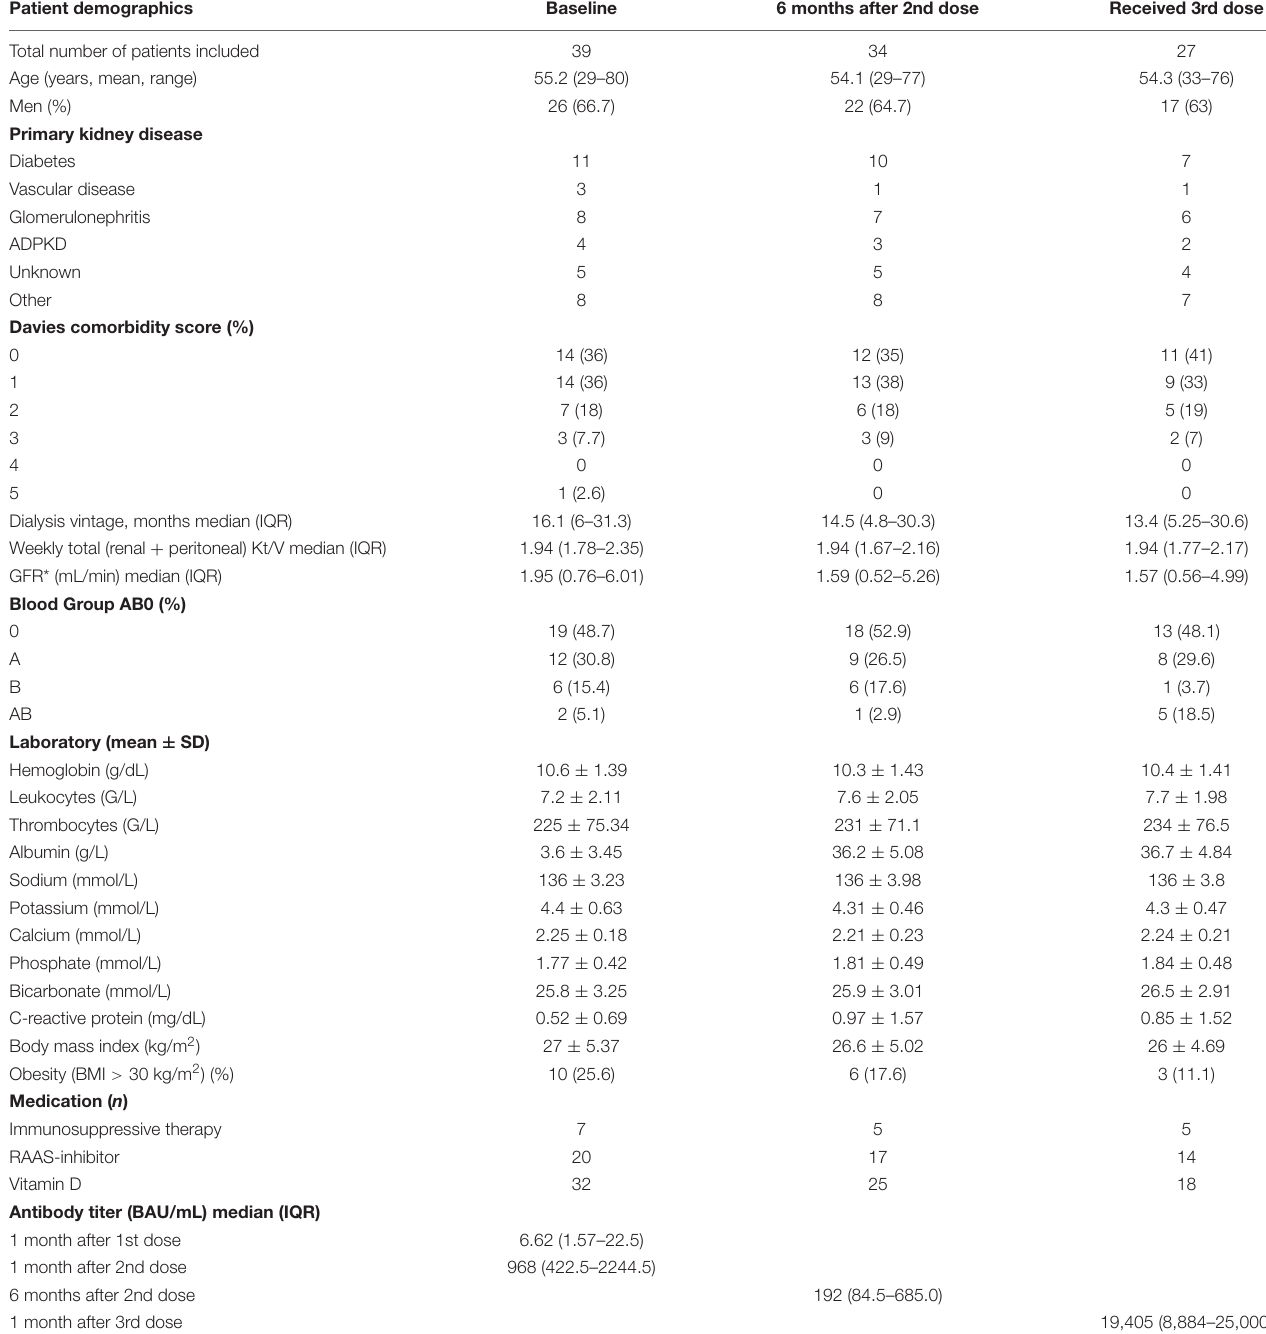
TABLE 1 | Characteristics of peritoneal dialysis patients vaccinated with mRNA-1273 vaccine. Patient demographics